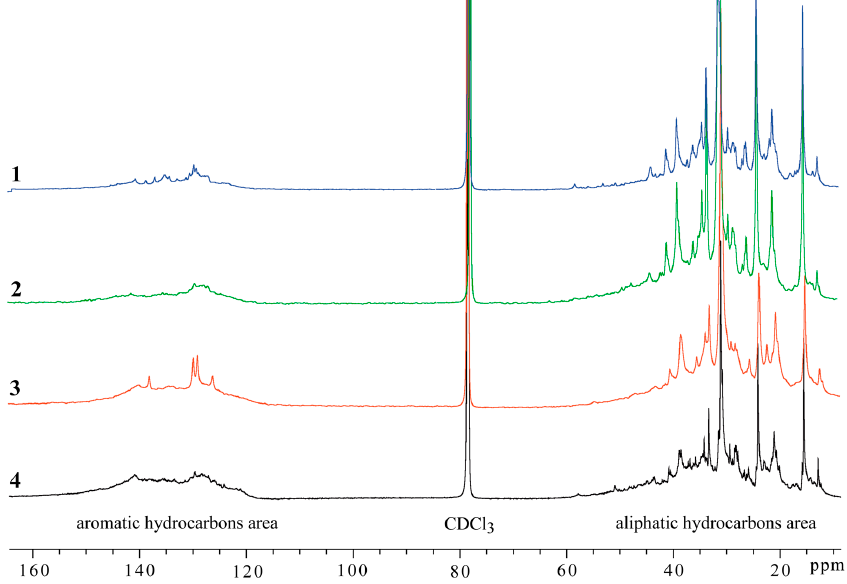
Figure 1. 13 C (175 MHz) NMR spectra of oil samples 1–4 in CDCl 3 .